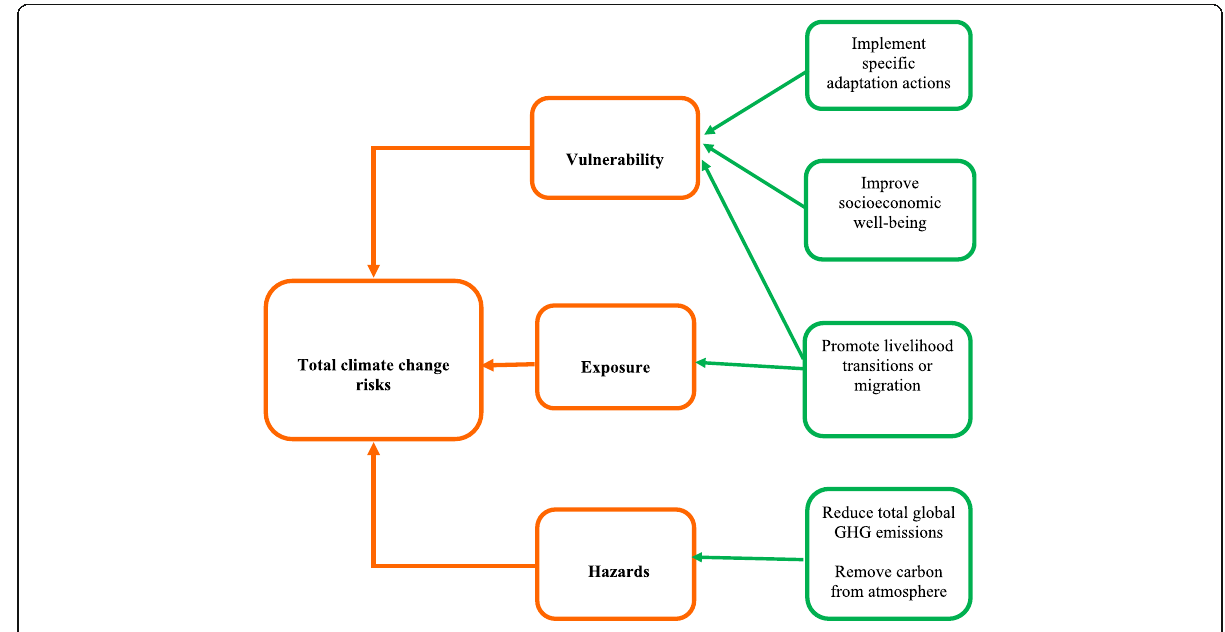
Fig. 1 Adaptation intervention pathways (adapted from IPCC, 2014 and simplified)